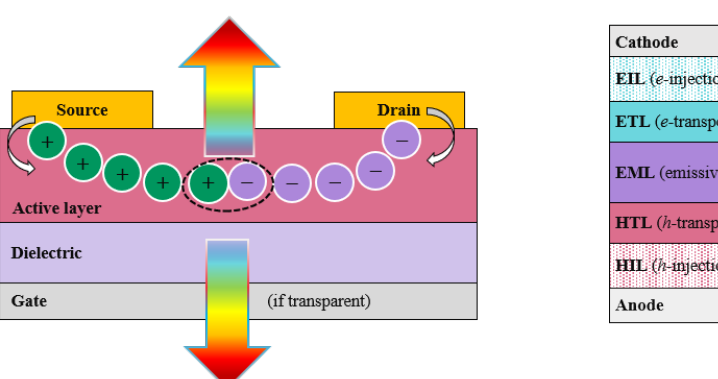
Figure 1. OLET vs. OLED device architectures. Simplified schematic drawings of ( left ) organic light emitting transistor and ( right ) organic light emitting diode structures. OLET is a three-terminals device, separated by a dielectric layer and an active organic material, with the charge transport dominated by lateral field-effect mechanism. OLED is based on a vertical stacked of different organic layers sandwiched between two electrodes, cathode and anode, and transport is dominated by tunnelling through adjacent layers. Each layer within the stack has a specific role (e.g., HIL: hole-injection layer, HTL: hole-transport layer, EML: emissive layer, where light emission occurs, ETL: electron-transport layer, EIL: electron-injection layer).